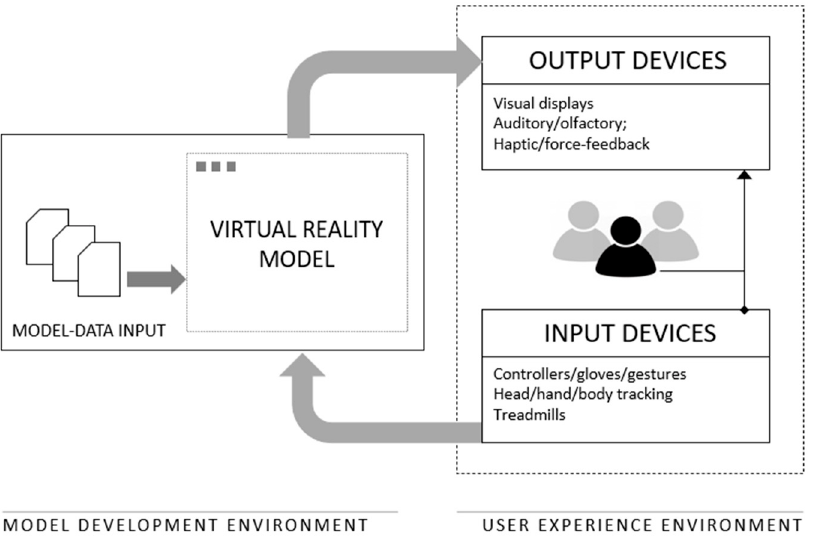
Figure 1. VR components where the model content and the combination of input and output devices define the users’ experience (adapted from Whyte and Nikoli ć 2018).